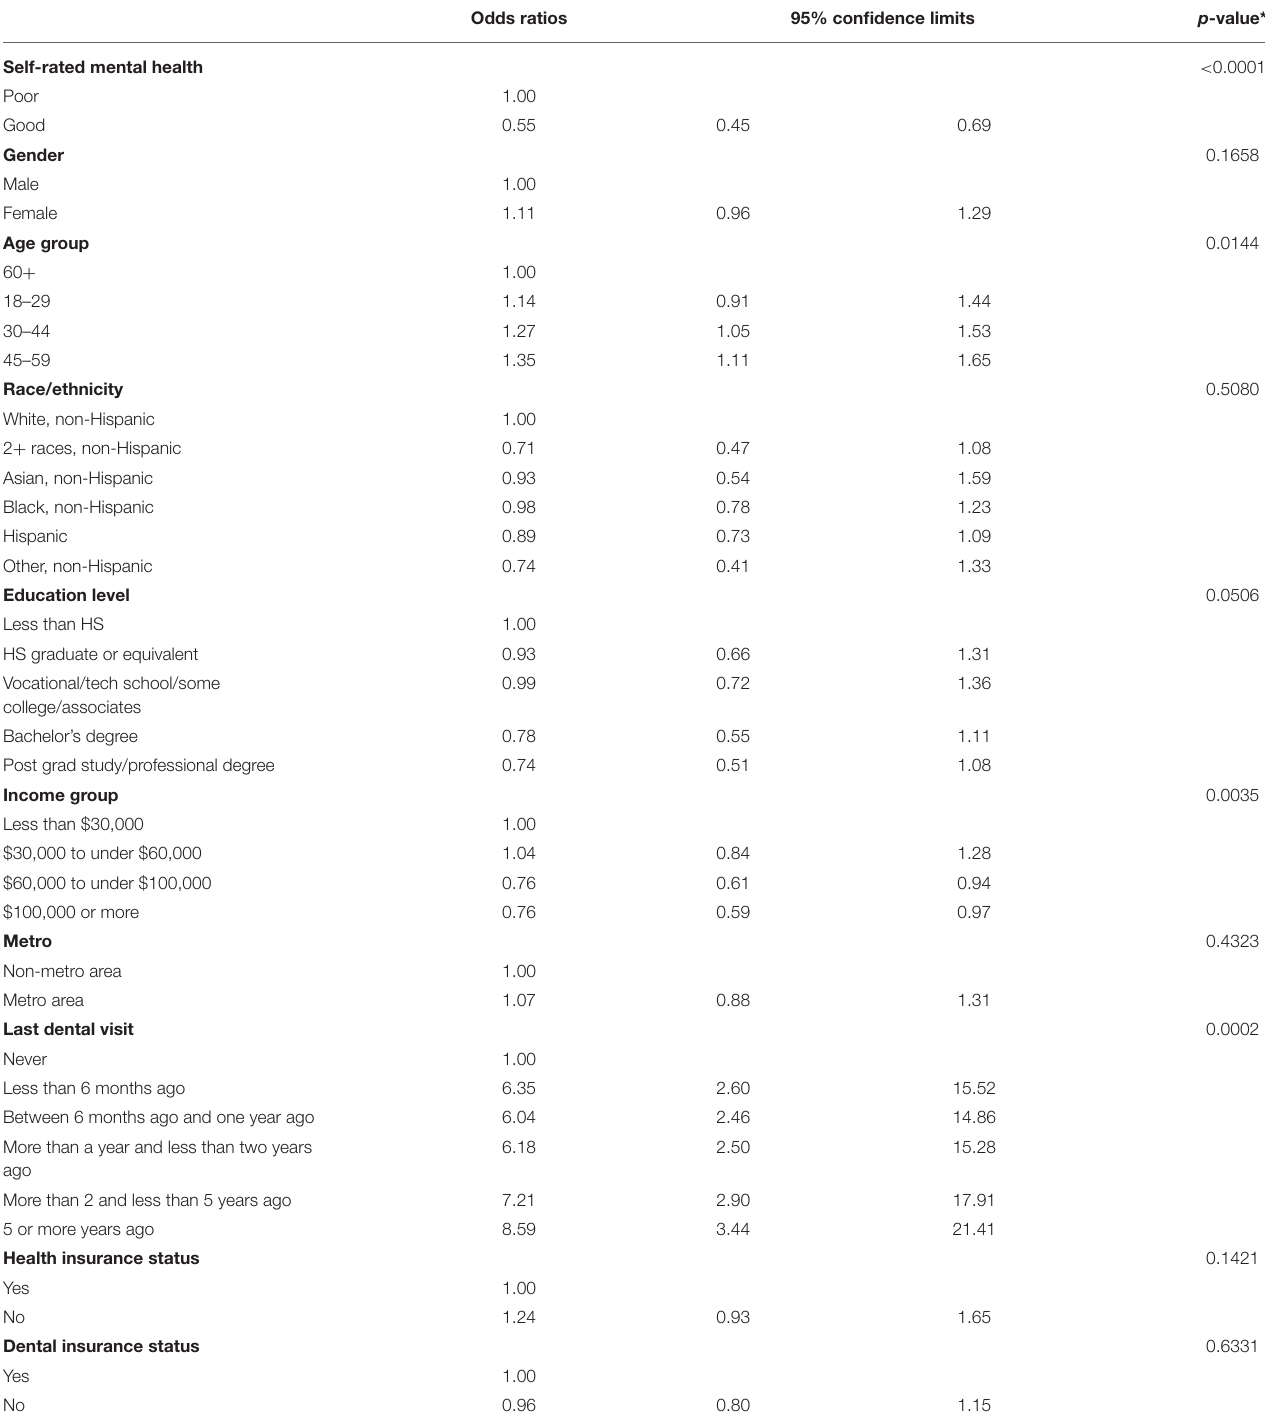
TABLE 3 | Association between Unmet Oral Health Needs and Mental Health from the State of Oral Health Equity in America survey 2021. Odds ratios 95% confidence